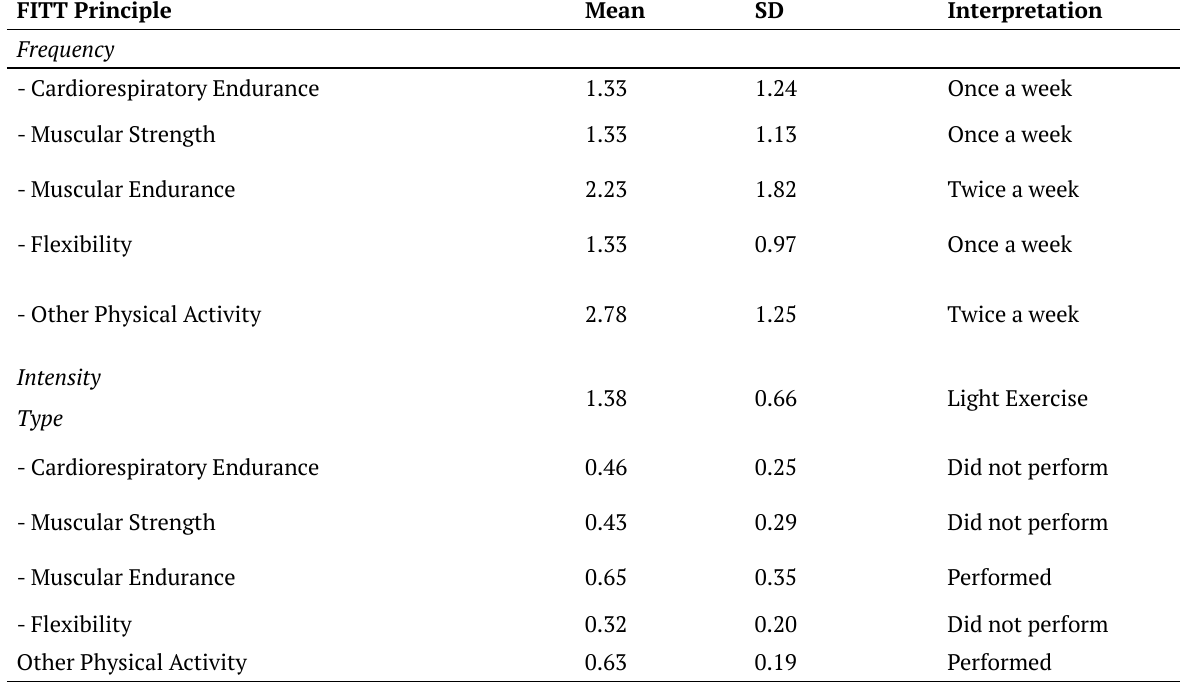
Table 3. Summary of the physical activities performed during the quarantine period using the FITT principle FITT Principle